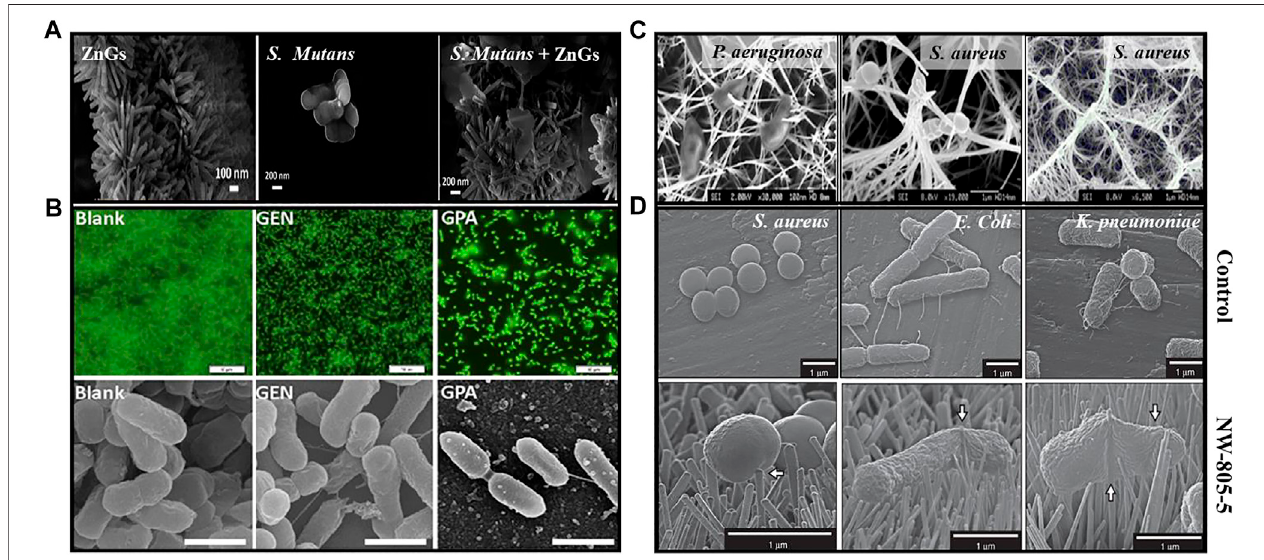
FIGURE 2 | (A) FE-SEM images of ZnGs, pure S. mutans and S. mutans in the presence of ZnGs (Zanni et al., 2016); (B) Confocal and FE-SEM images of P. aeruginosa bio fi lm(asblank),withgentamicin(GEN)and withAuNPsloadedgentamicindrug(GPA) (Muet al.,2016); (C) FE-SEMimages ofNanowire-piercedbacterial cells after 1h incubations (Diu et al., 2014); (D) FE-SEM images of Bacteria following 3-h static incubation on fl at titanium alloy (control) and TiO 2 nanopillar surface (NW- 805 – 5) (Jenkins et al.,